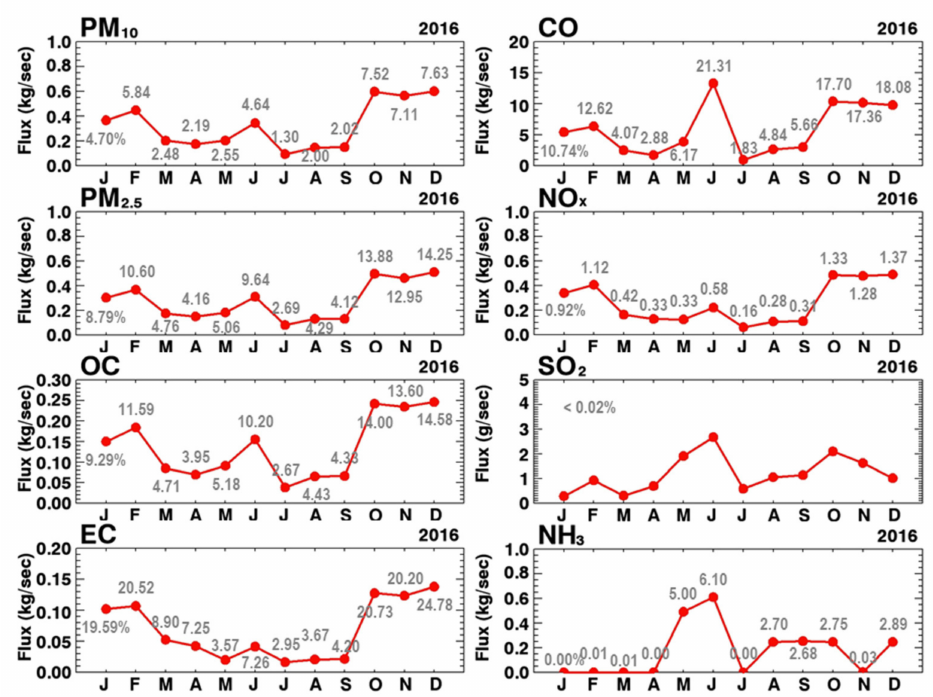
Figure 6. Monthly variations of CRB emissions for gaseous particulate species over South Korea (unit: g s − 1 for SO 2 , kg s − 1 for other species). The numbers (unit: %) colored in gray represent contributions of CRB to total emission considering anthropogenic, biogenic, fire, and CRB